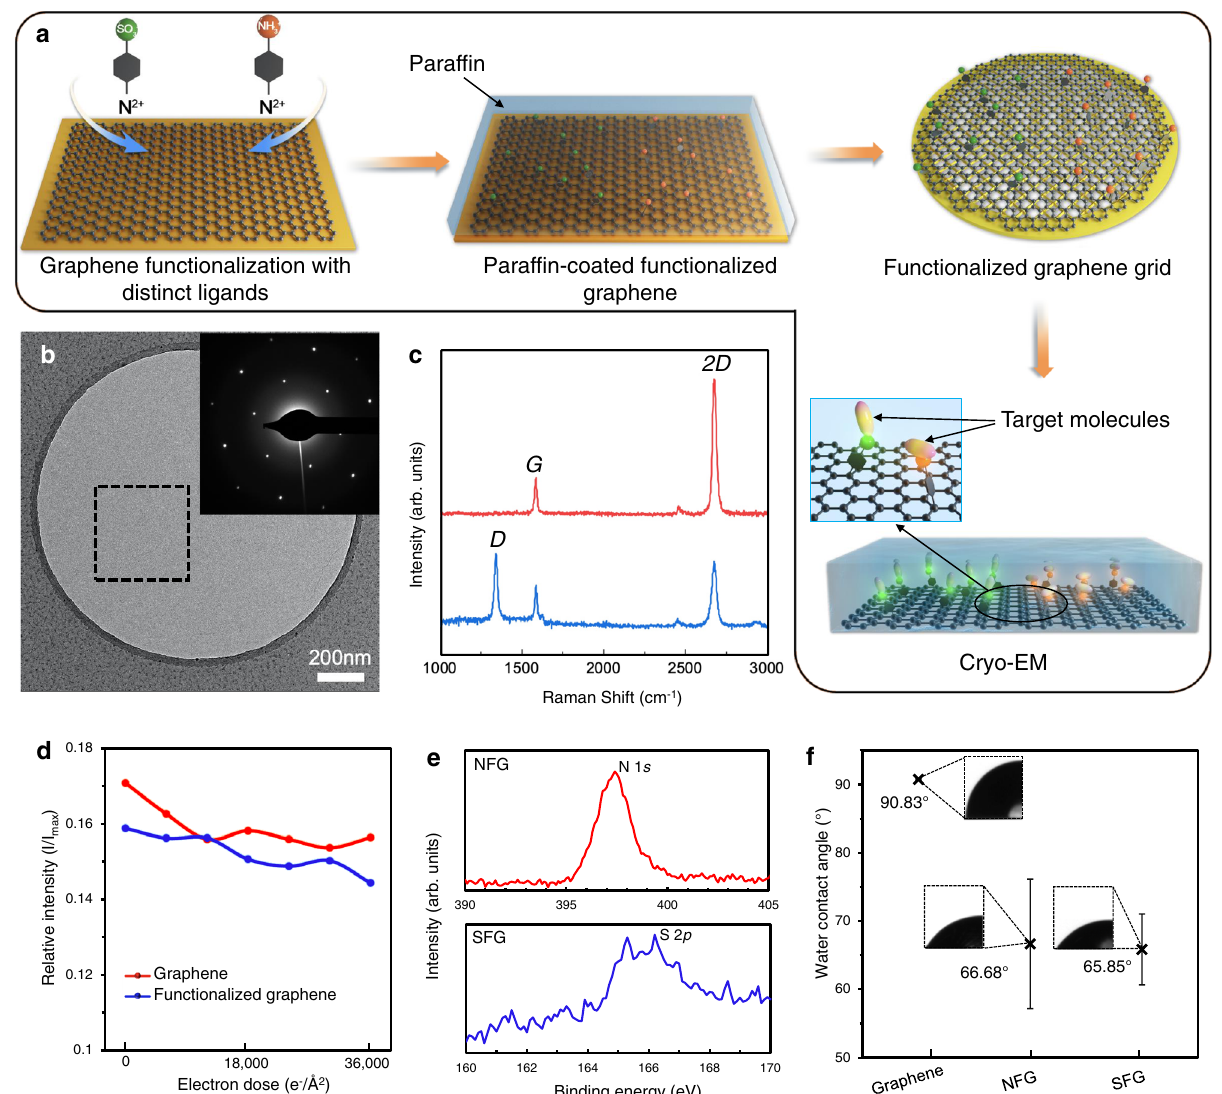
Fig. 2 | Characterization of the functionalized graphene grid. a Scheme of the functionalized graphene for cryo-EM analysis. b A representative TEM micrograph of the suspended functionalized graphene membrane. The inset is the diffraction pattern of the selected area (indicated by the dotted box). c Raman spectra of graphene (red) and functionalized graphene (blue). d The relative intensities of graphene (red) and functionalized graphene (blue), de fi ned by the ratio of third- order integrated Bragg intensity (I) over the fi rst-order integrated Bragg intensity